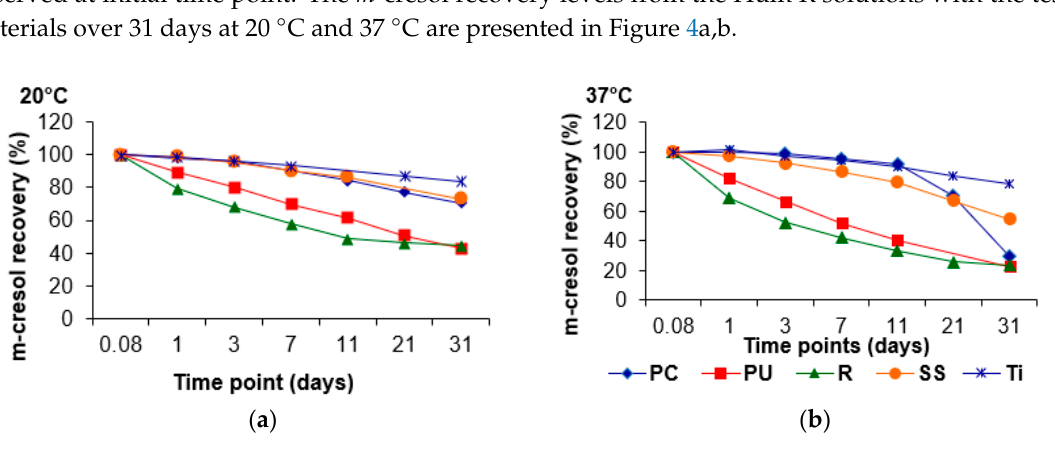
Figure 4. ( a ) m -Cresol recovery over time for each test material at 20 ◦ C and ( b ) 37 ◦ C using analytical Figure 4. ( a ) m- Cresol recovery over time for each test material at 20 °C and ( b ) 37 °C using analytical method